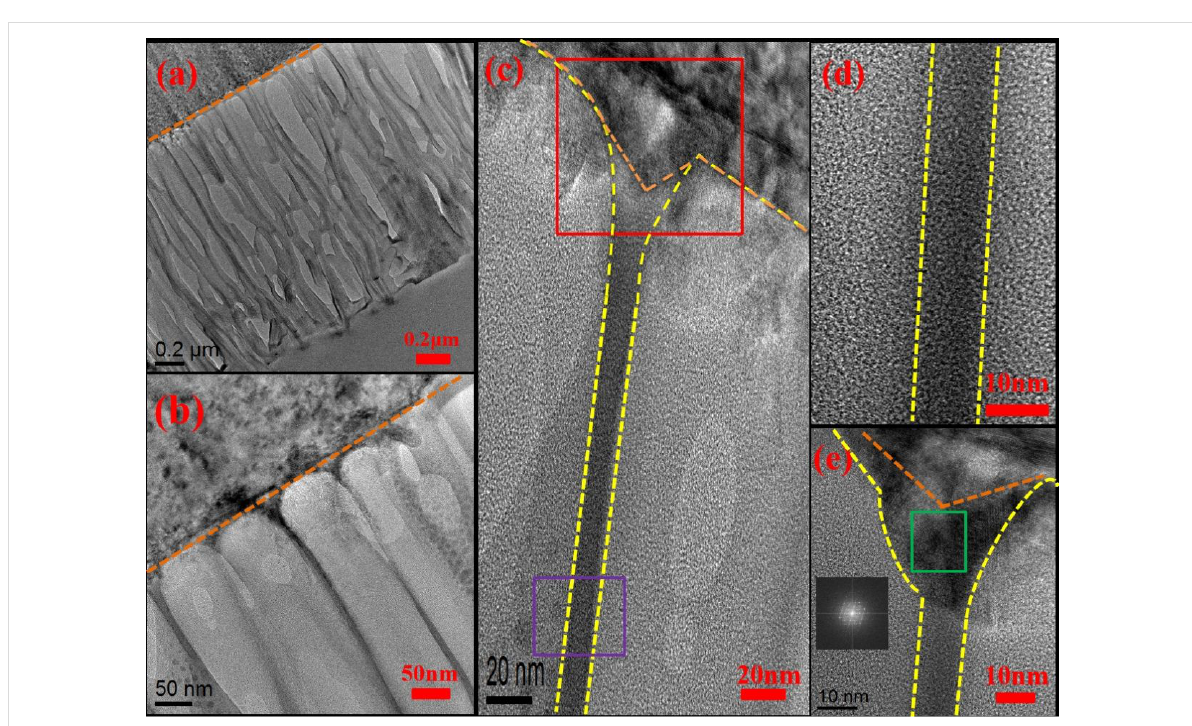
Figure 5: Transmission electron microscopy measurements for AAO80 obtained at different magnifications: (a) complete pores exist at the sapphire substrate; (b) magnified view of (a); (c) the structure between pores; (d) a magnified view of the purple area shown in (c); (e) a magnified view of the red area shown in